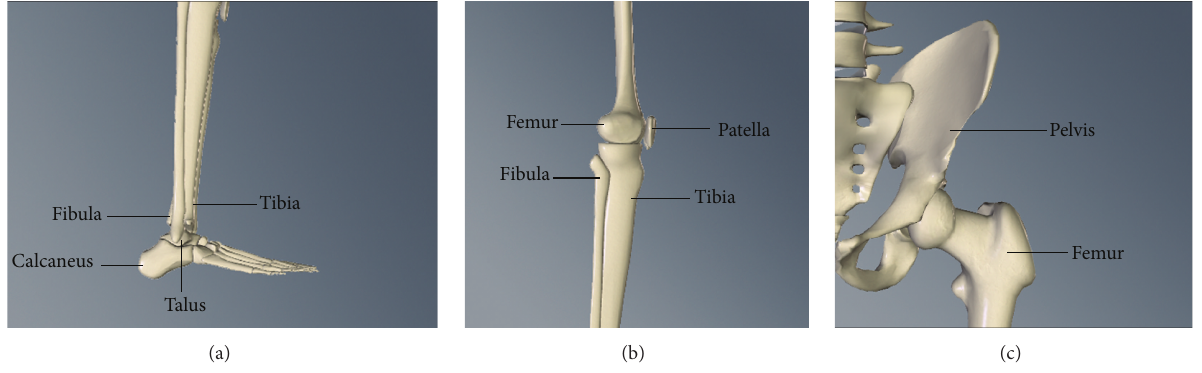
Figure 3: Anatomy of the human joints: (a) ankle, (b) knee, and (c) hips. Powered by BioDigital [66].